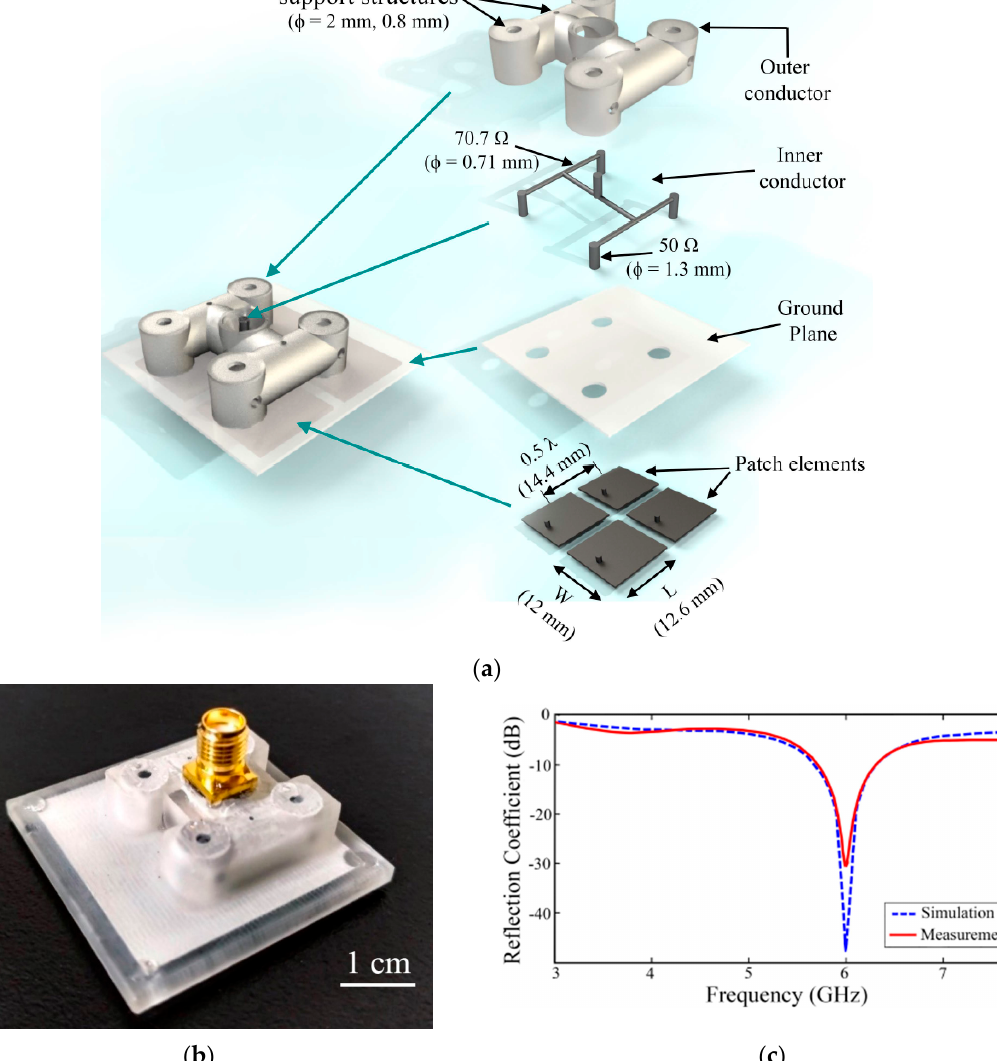
Figure 15. ( a ) Exploded view of the antenna array with 3D-printed Support structure and EGaIn patch elements; ( b ) fabricated antenna; ( c ) measured vs. simulated reflection coefficients as a function of frequency [52].